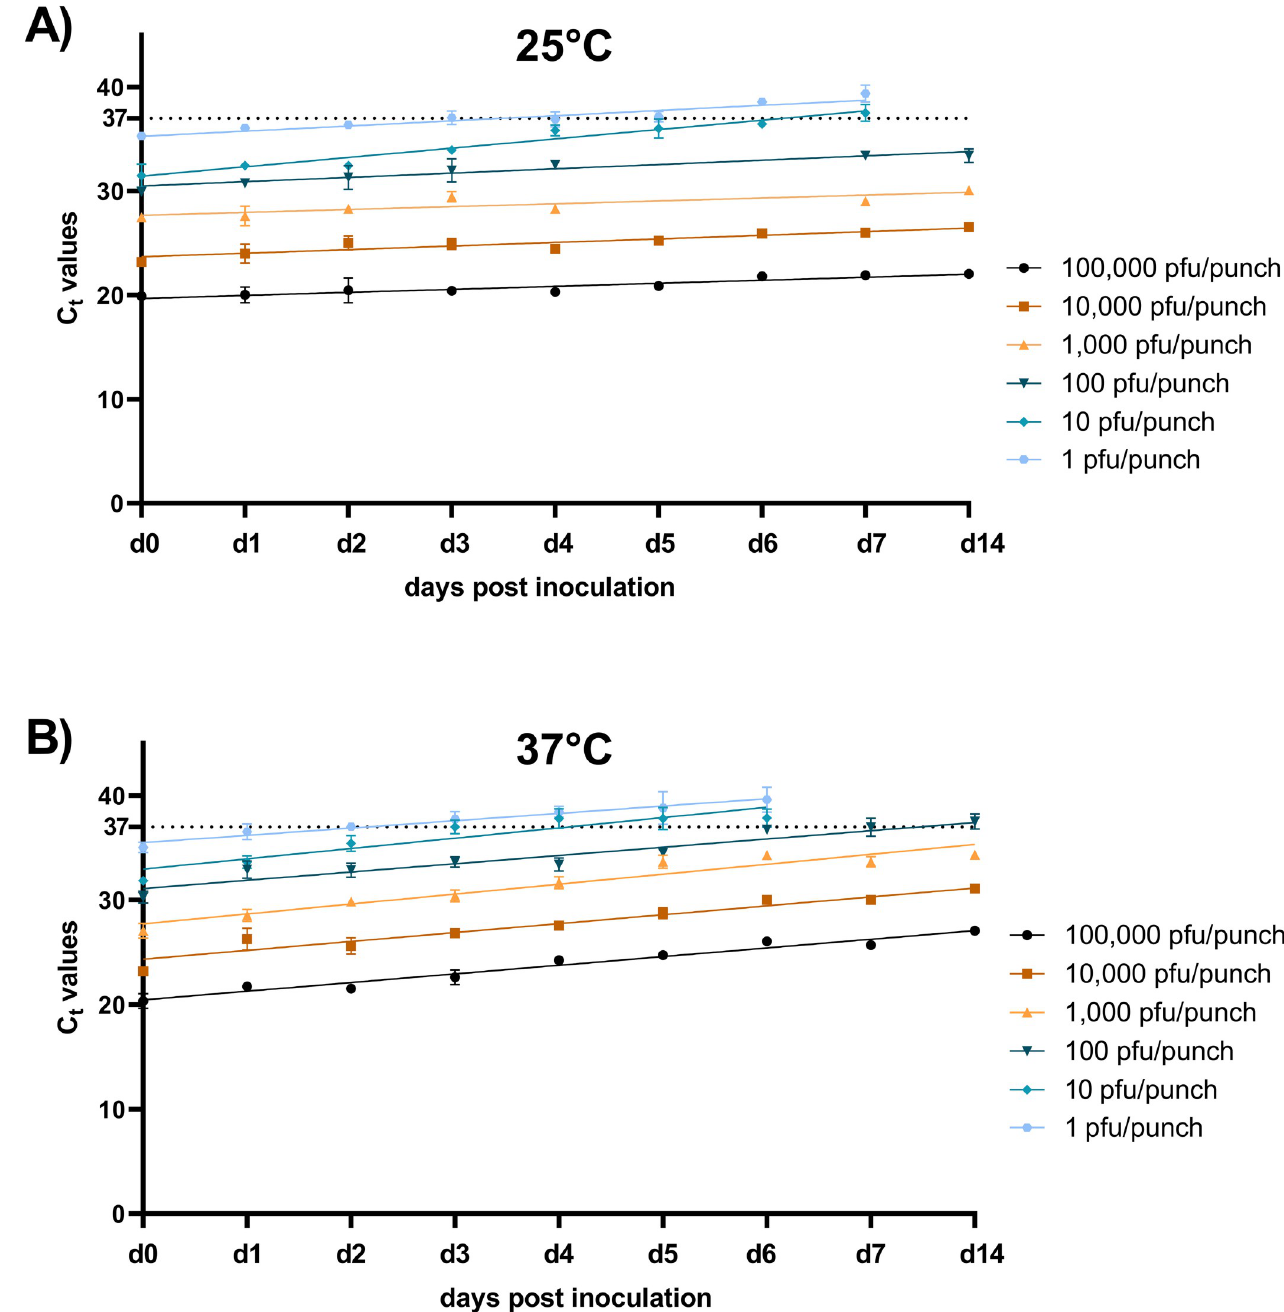
Fig 3. FTA card stabilization of YFV RNA decrease at high temperature. The vaccine strain of YFV, 17D-204, was diluted in PBS, spotted onto punches from FTA cards and placed at RT (~25˚C) or 37˚C for two weeks. The dotted line at C t value 37 indicates the cut off for YFV RNA positivity and is based on cut-offs used in the molecular diagnosis of YFV in the field. Points represent the average of two experiments where extracts from one punch were made and were fit using a linear regression. https://doi.org/10.1371/journal.pntd.0010487.g003 RNA has been frequently documented in regions endemic to YFV where high humidity is common [28]. To assay if the reported loss in RNA yield was due to the card having absorbed moisture from the air prior to inoculation, cards were pre-incubated in the humidity chamber